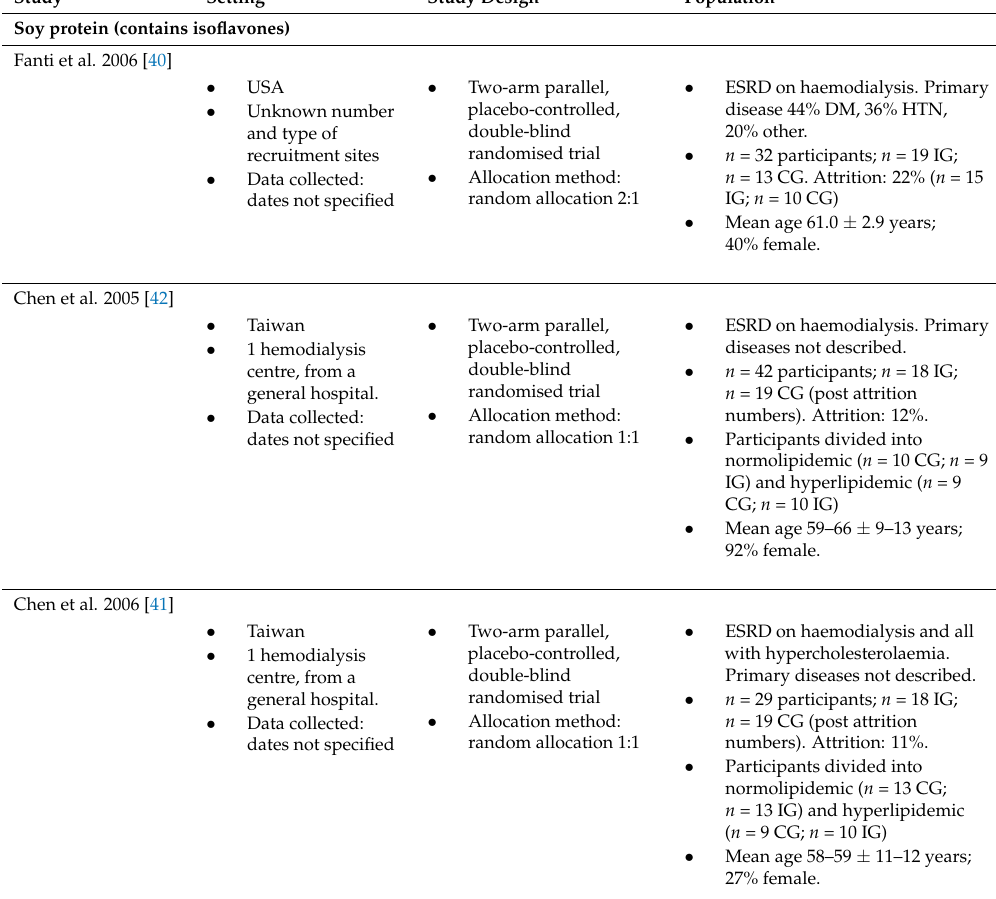
Table 1. Summary of included